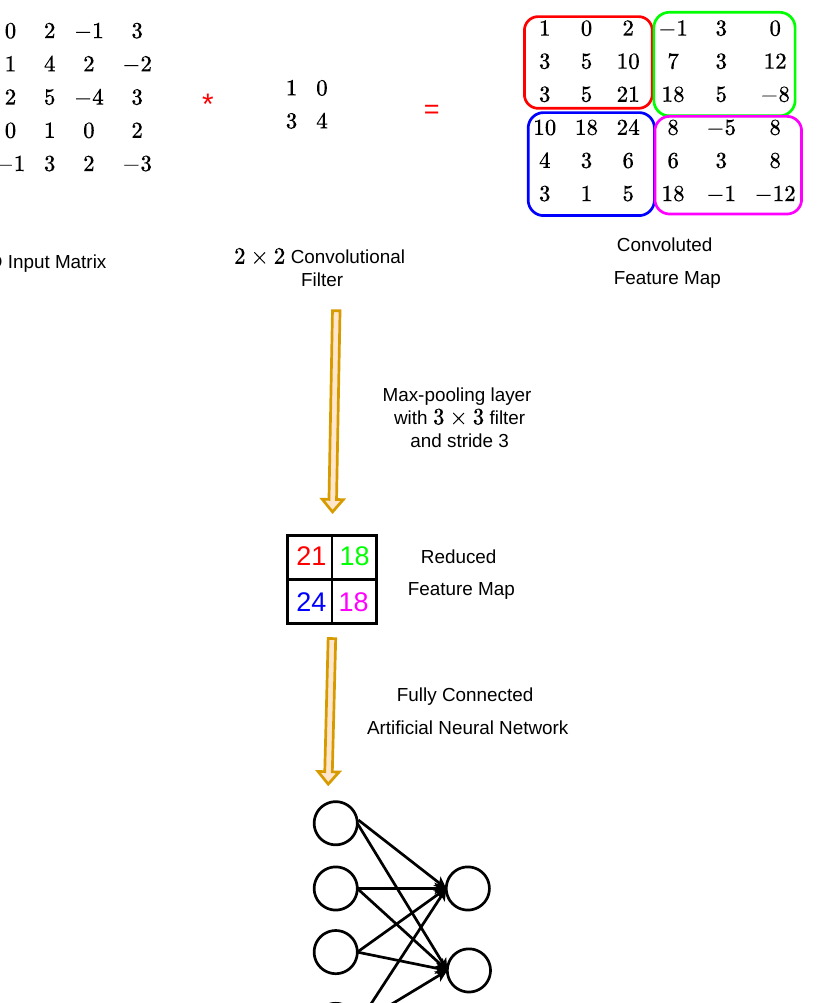
Figure 4. A general illustration of the convolutional layer, the pooling layer, and the fully connected layer in a